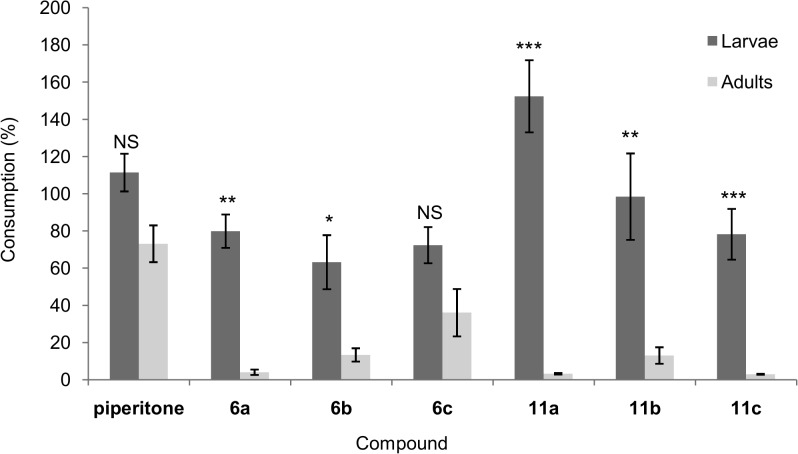
Effects of piperitone and hydroxy lactones (6a-c and 11a-c) on the feeding of Alphitobius diaperinus larvae and adults in no-choice tests.Data are expressed as percentages of control consumption. Values represent the means of four replicates, each set by using ten larvae or adults (n = 40). The standard error is indicated on each bar. * p < 0.05; ** p < 0.01; *** p < 0.001; NS: not significant (Student’s t-test).